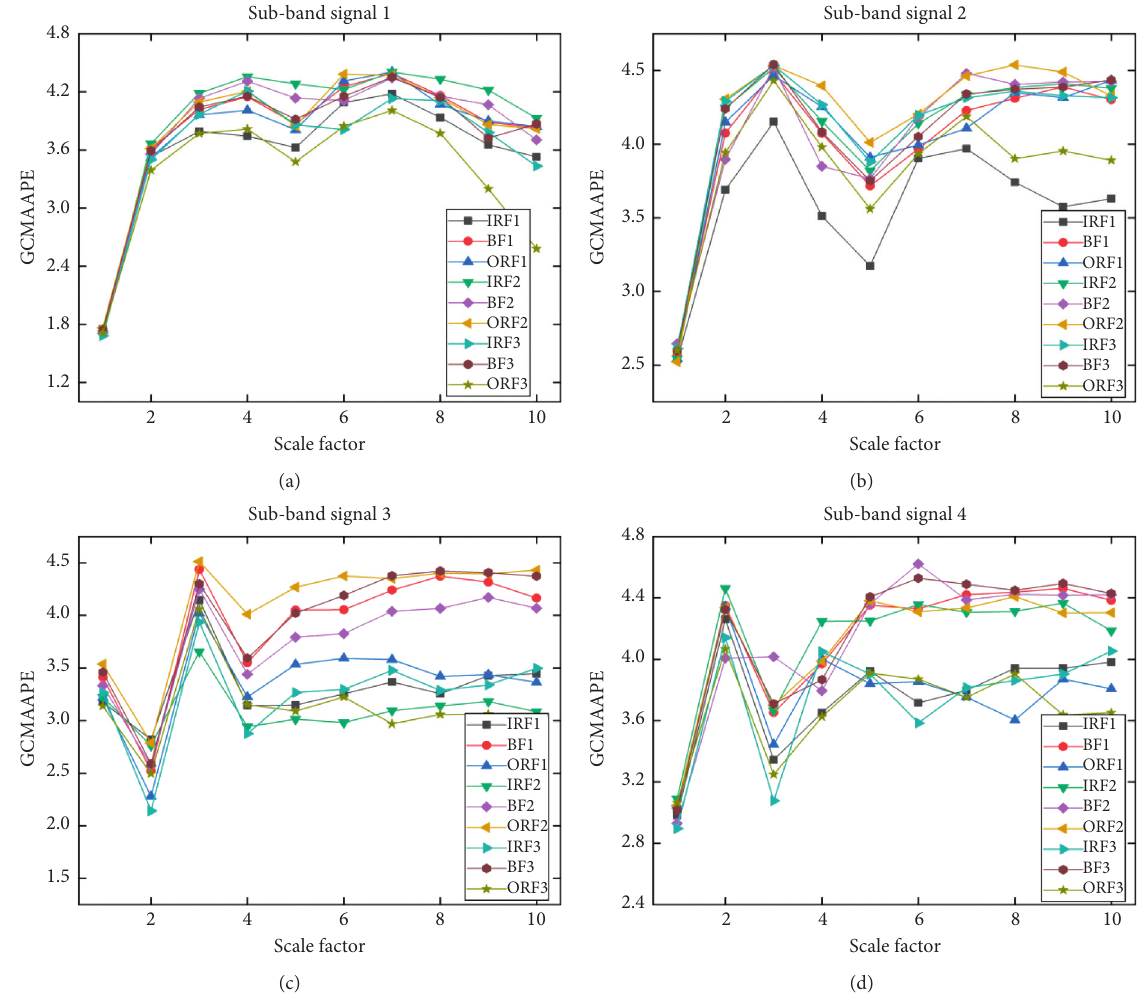
Figure 12: GCMAAPE value of four subband signals over 10 scales under nine different working conditions. (a) Subband signal 1. (b) Subband signal 2. (c) Subband signal 3. (d) Subband signal s indicates the scale factor. The classifier used in each max method is DBN. Each method is repeated 25 times to avoid